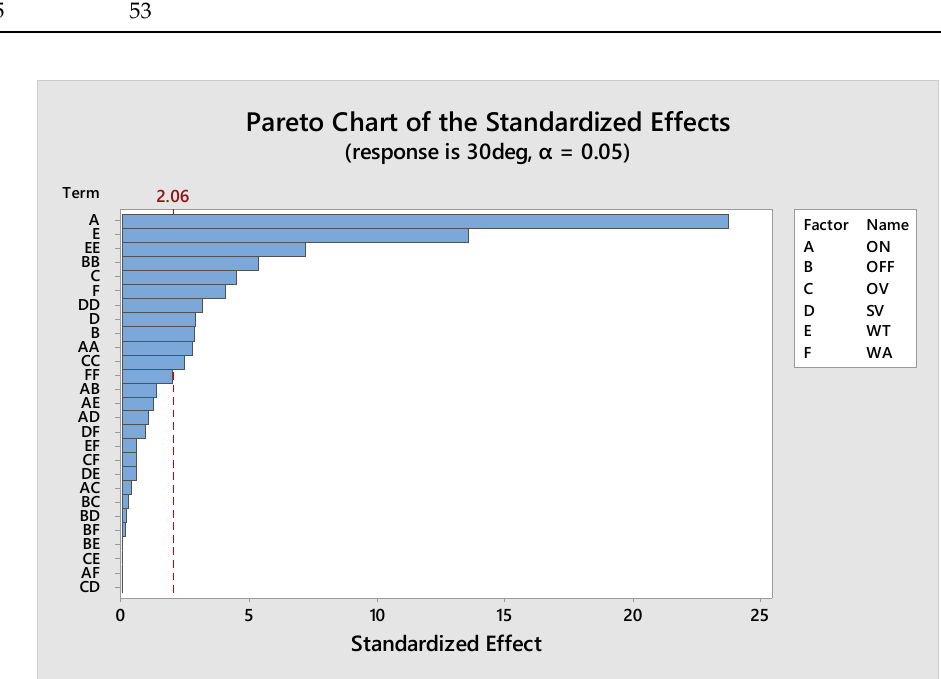
Figure 3. Pareto chart response surface model for 30° corner.